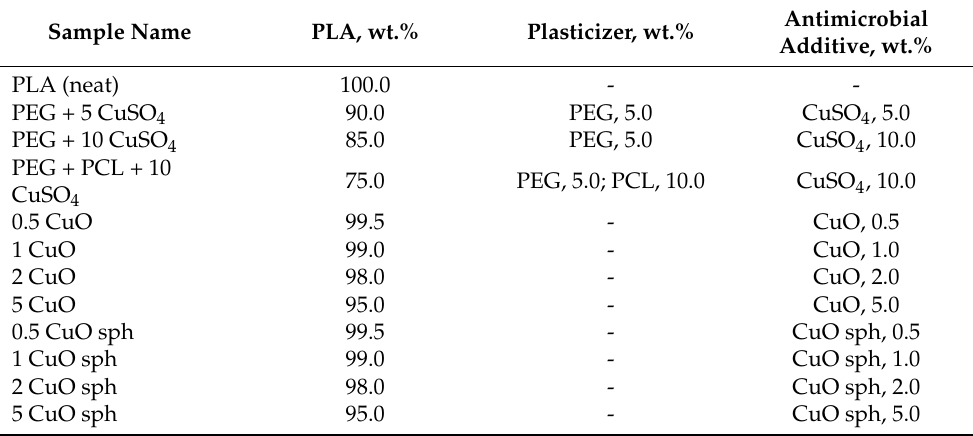
Table 2. Compositions of PLA-based materials with various